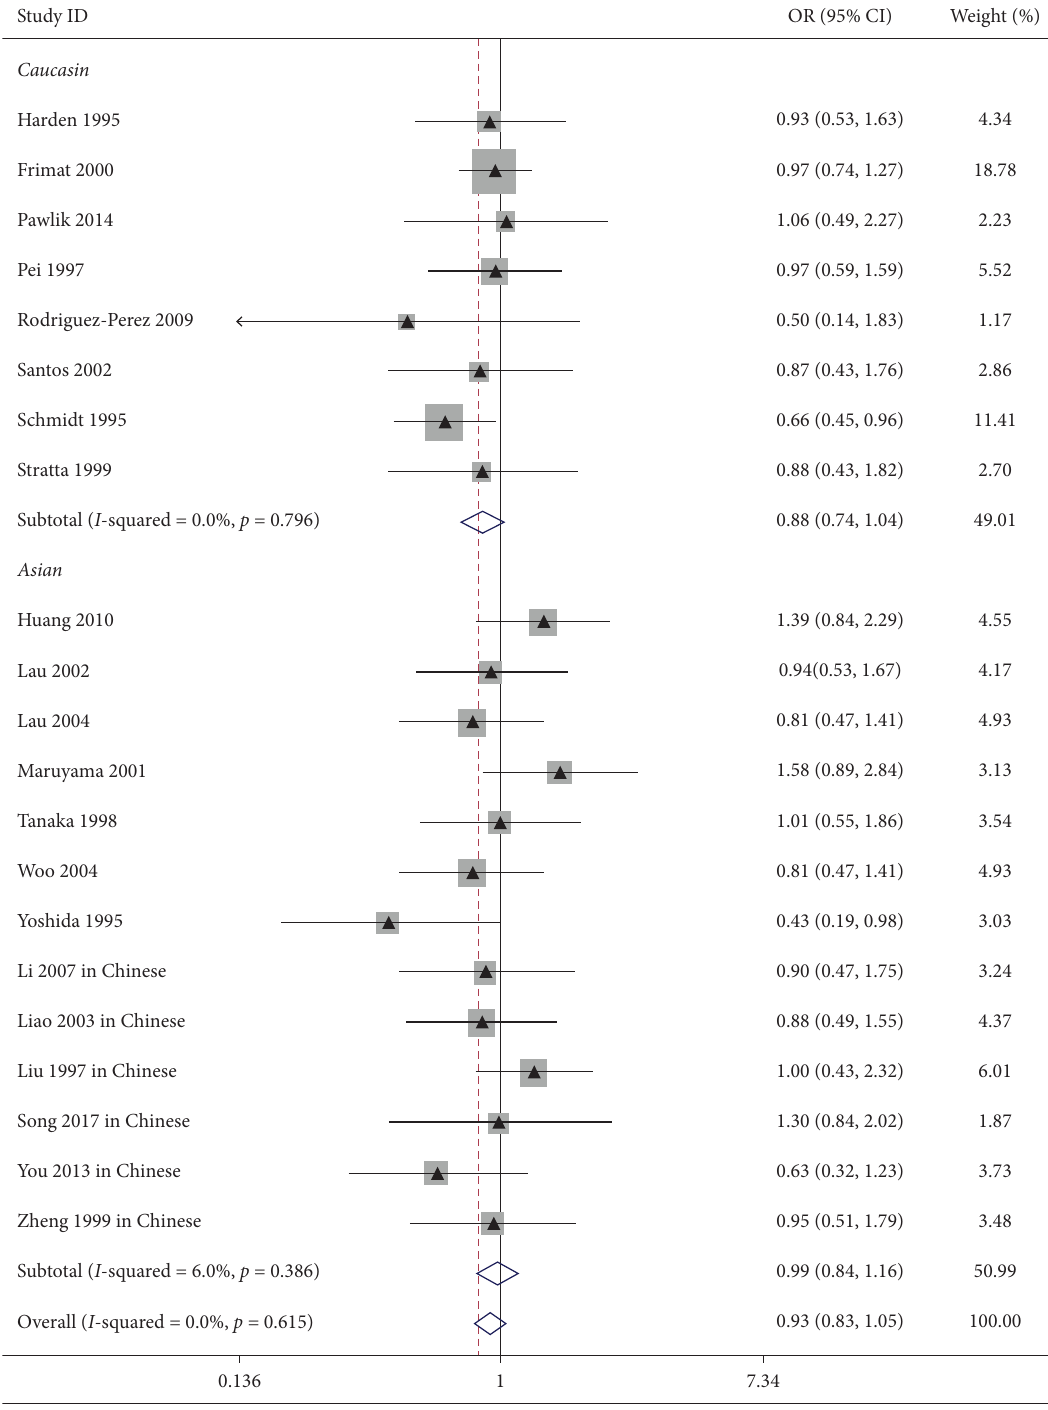
Figure 4: Forest plot about the link between ACE I/ D gene polymorphism and IgAN susceptibility (genotype ID vs. genotype DD +II). Evaluates of pooled OR for IgAN showed that the ACE gene locus ID genotype was not associated with